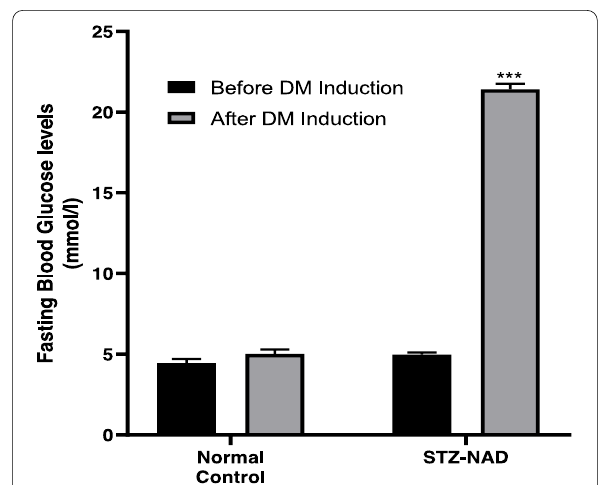
Fig. 1 Fasting Blood Glucose levels (mmol/l) of SD rats before and after induction of diabetes. Values were expressed as mean ( n 30). Data were analyzed using 2‑way ANOVA followed by Sidak’s =